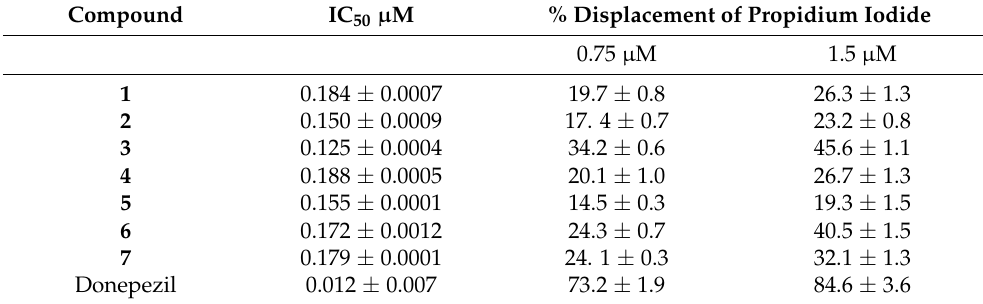
Table 2. Inhibition of AChE and displacement of propidium iodide from the